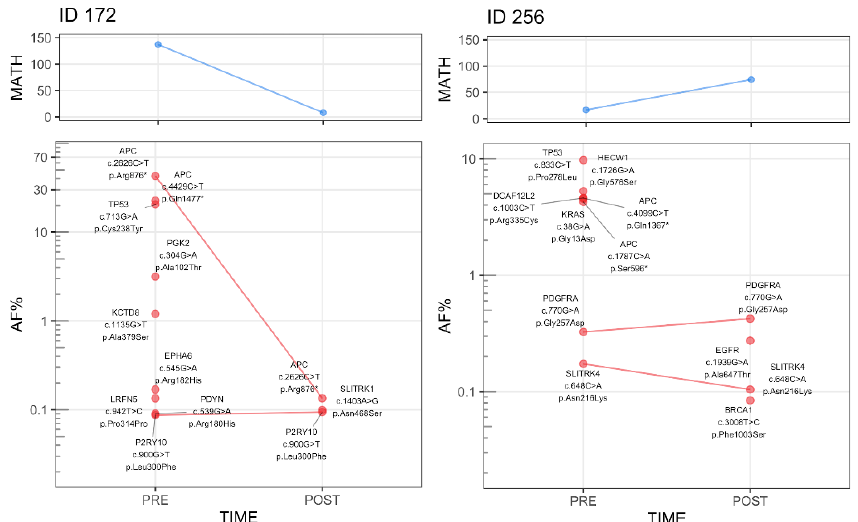
Figure A4. Most frequently mutated genes by MATH group. Mutation landscape for ( a ) pre-induc- tion and ( b ) post-induction plasma. Filled tiles represent mutated genes. Each column represents a patient. Patients are grouped and colored by MATH (High, Low, and Undefined); Undefined are samples with 0 or 1 somatic mutations. The top 10 most frequently mutated genes and NRAS and BRAF are presented. “Other” refers to other genes or no mutations for samples with 0 variants.